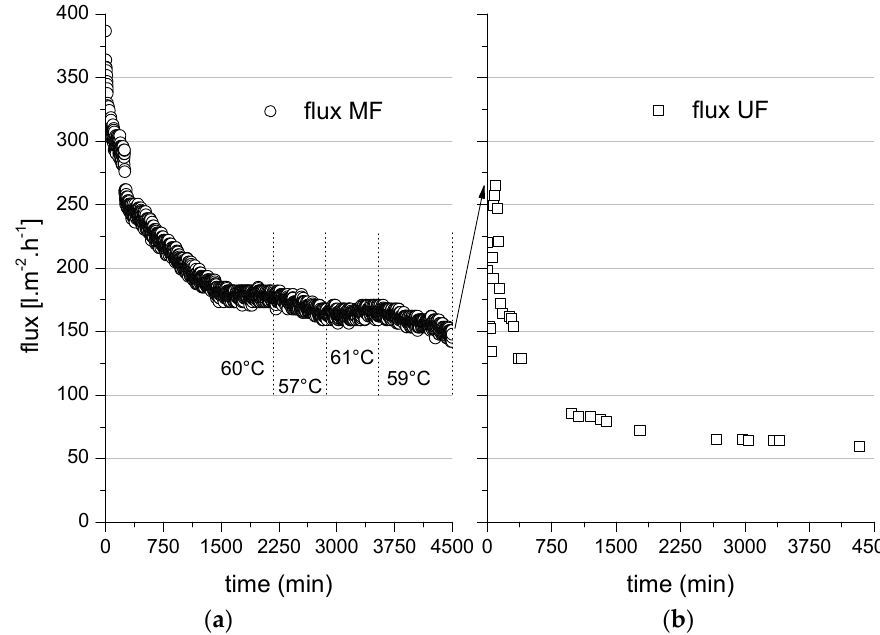
Figure 5. Permeate flux versus time for a 0.1-µm MF ceramic membrane ( a ) as a first treatment step (feed = bleaching effluent) followed by a 20-kDa UF membrane ( b ) as second treatment step (feed = MF permeate). TMP = 2 bar; temperature = 60 °C except where shown